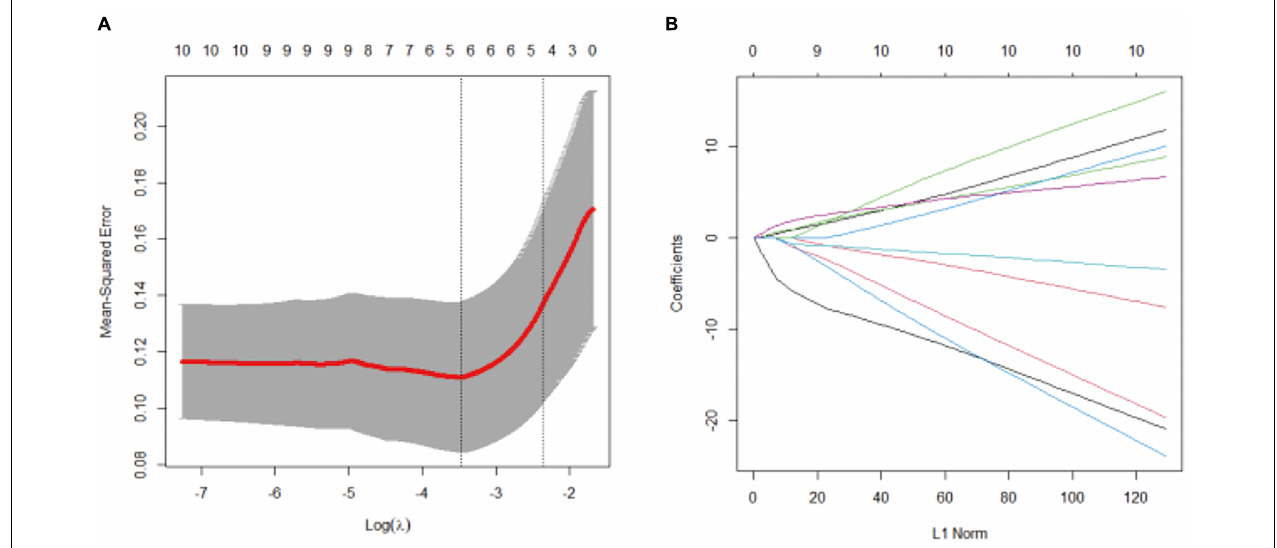
FIGURE 2 | LASSO regression analysis. Variable selection by LASSO binary logistic regression model. (A) Selection of tuning parameter ( λ ) in the LASSO regression using 10-fold cross-validation via minimum criteria. five variables with non-zero coefficients were selected by optimal lambda. (B) LASSO coefficient profiles for clinical